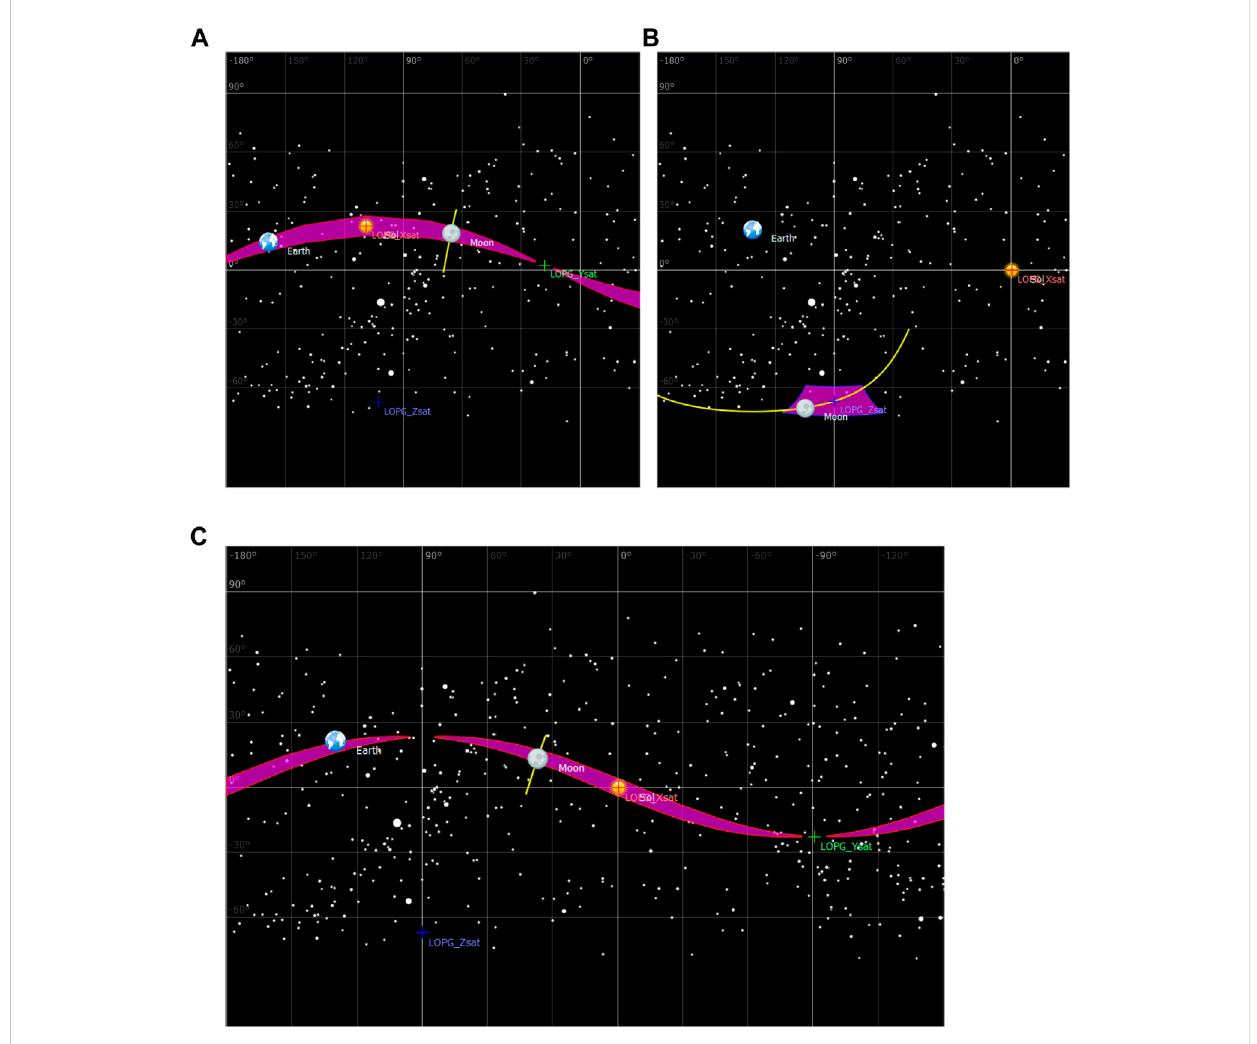
FIGURE 25 (A) : Field-of-regard (total accessible FOV, taking into account the rotation of the 1-axis articulation on which the instrument is mounted) of the cMENAinstrument,atagivenpointoftheorbit.The fi eld-of-regard(FOR),asprojectedonthesky,isshowninmagenta. (B) :cLENAFOV(inmagenta)near periapsis.TheyellowlineisthetrackofthecenteroftheFOV,fortheportionoftheorbitclosetoperiapsis,asprojectedonthesky. (C) :Field-of-regardof the cUVIS instrument, in magenta, as projected on the